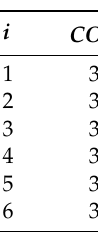
Table 7. Robustness of the wafer fab after improving the performance in optimizing each